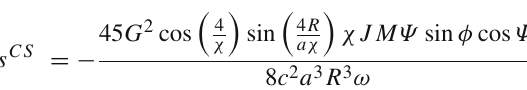
μ ˆ n is orthogonal − E μ ( 1 ) ( 2 ) plane, and μ φ ( 2 ) is